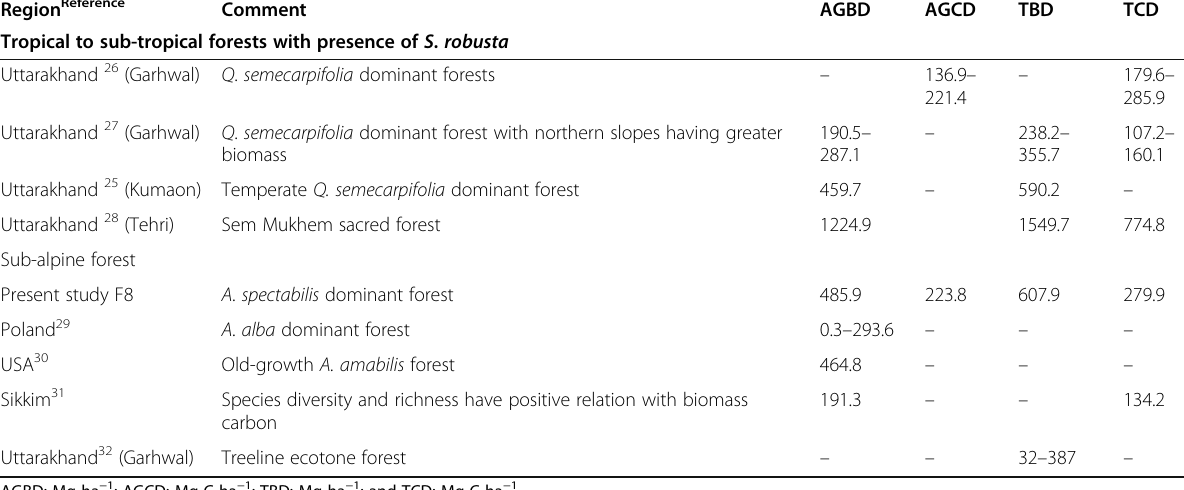
Table 6 Comparative review between biomass and carbon stock estimates in similar forest types reported under previous investigations and the present study